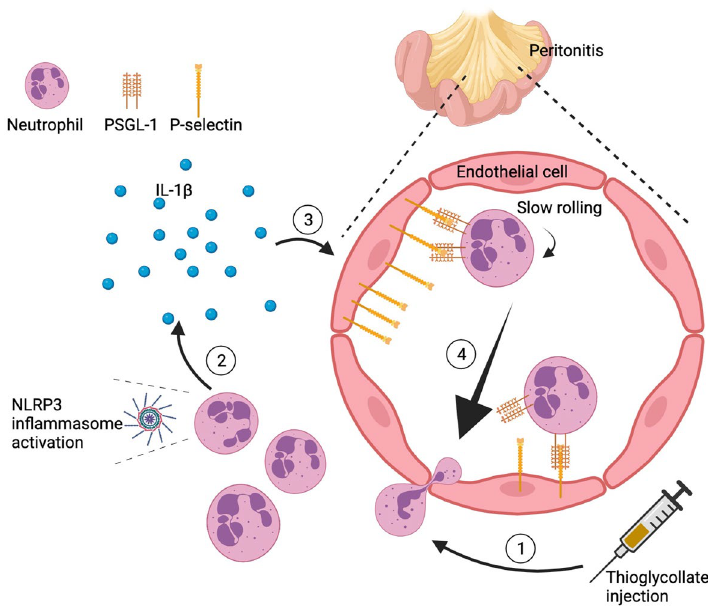
Figure 5. A likely interpretation of our results. 1: Thioglycollate injection initiates neutrophil-predominant peritonitis. 2: Neutrophils induce IL-1β production likely through NLRP3 inflammasome activation. 3: Released IL-1β activates endothelial cells leading to increased P-selectin expression. 4: Increased P-selectin expression results in slower neutrophil rolling and higher neutrophils